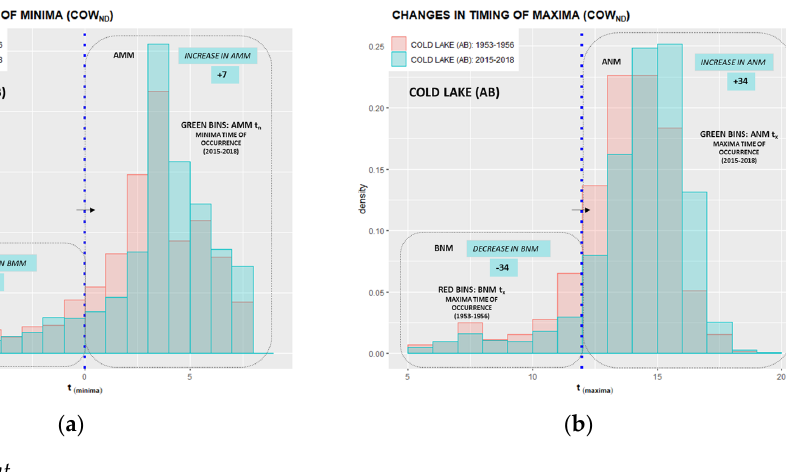
Figure A14. Cont